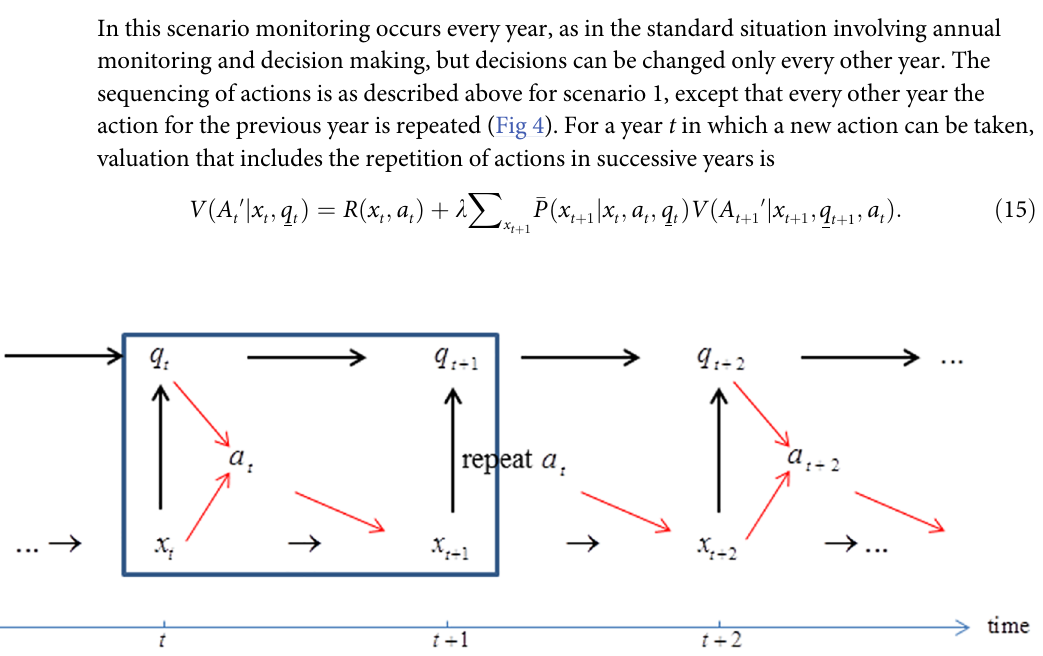
Fig 4. Scenario 3: Biennial decision making and annual monitoring. Action a t is selectedbased on system state x t and model state q t . Realizedsystem state x t +1 is identifiedthrough monitoring in year t +1. Model state q t is updatedto q t +1 with Bayes’ theorem. Action a t is repeatedin year t +1. This sequence,with the same action taken in successiveyears, is repeated over the remainder of the time frame.